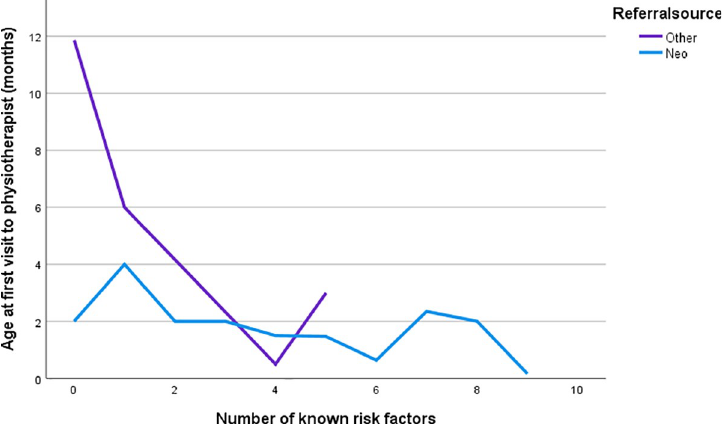
Fig 1. The interaction between referral source and number of risk factors. The total number of known risk factors before 5 months corrected age (X-axis) and the mean corrected age at first visit to physiotherapist in months (Y-axis). The lines represent the referral